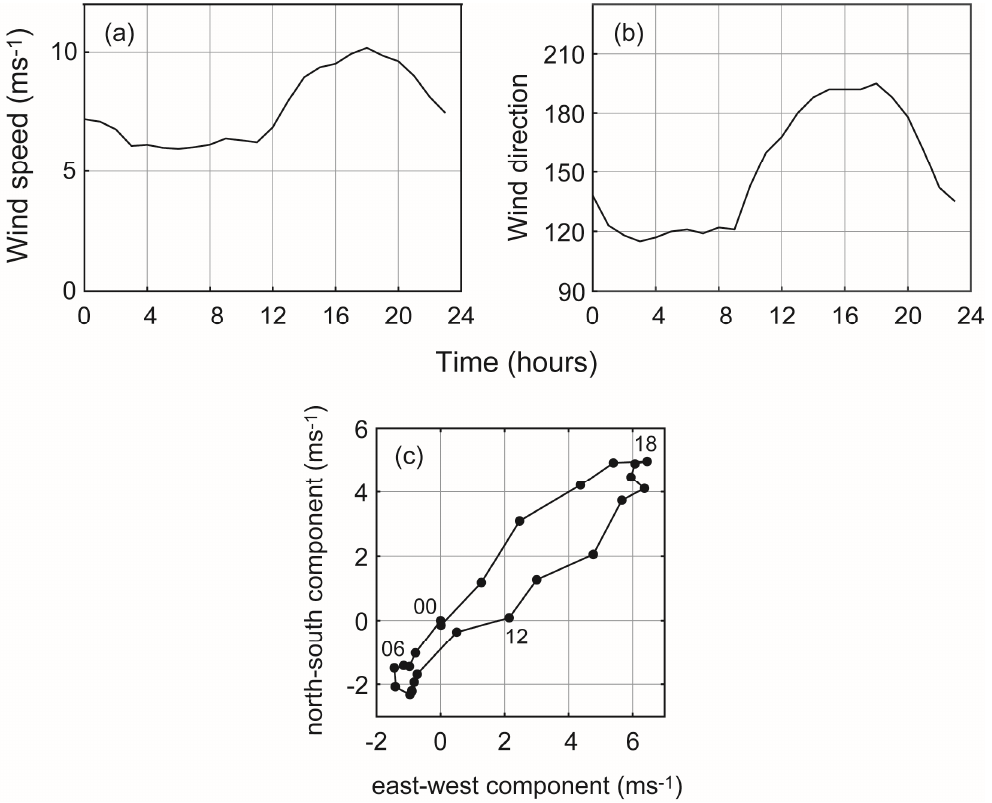
Figure 6. Time series of mean ( a ) wind speed; and, ( b ) wind direction for the period 22–30 January 2016. ( c ) hodograph plots of ( a , b ) with synoptic winds removed. The numbers on the hodograph represent local time in hours. Data Rottnest meteorological station.